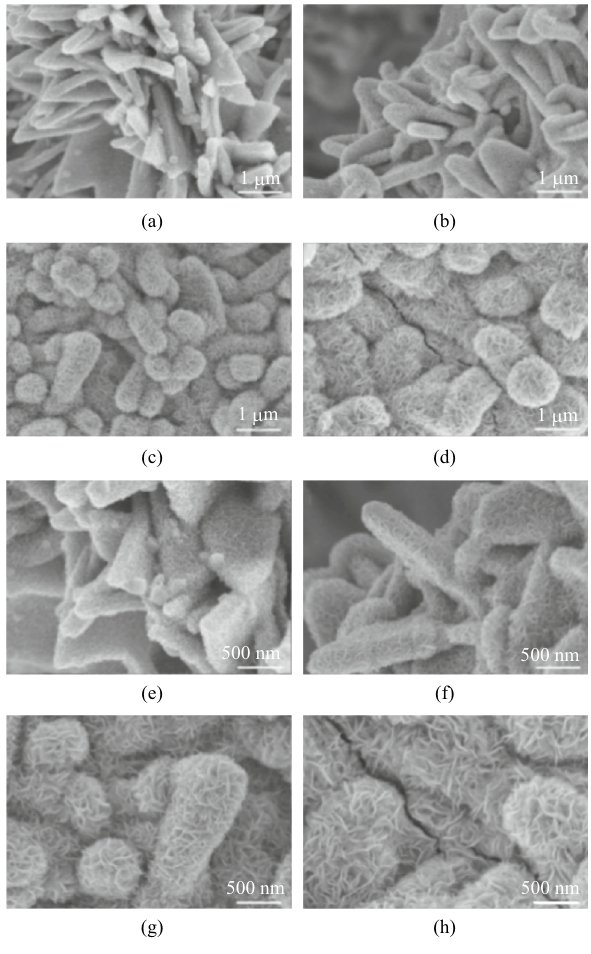
Fig. 2 SEM images of MOS/COS/CC electrocatalysts with differ- ent synthesis time. a , e 2 h, b , f 4 h, c , g 6 h, and d , h 8